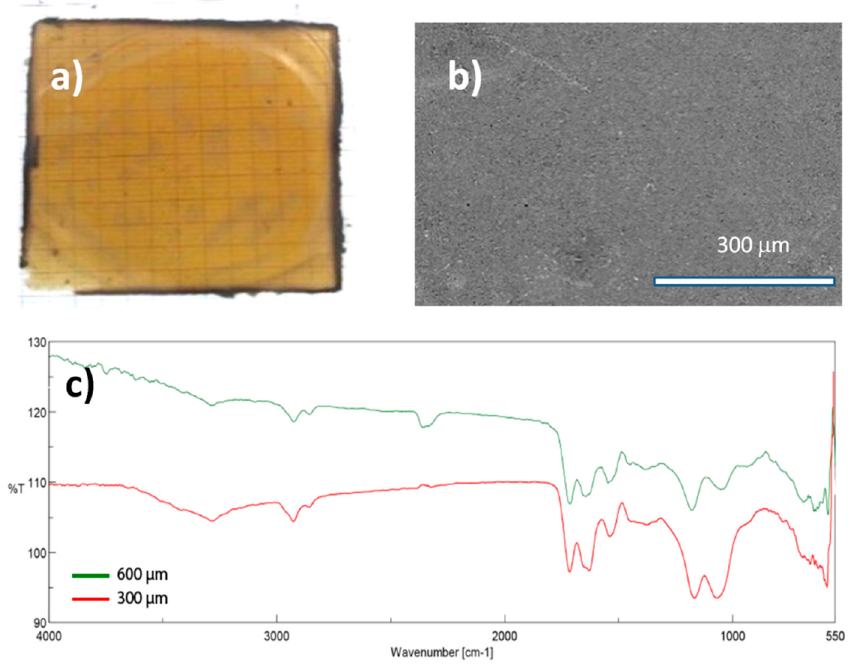
Figure 4. ( a ) Photographs of bioplastic from 300 µm rapeseed cake; ( b ) FE-SEM picture of film morphology from 300 µm rapeseed cake; ( c ) FT-IR spectra of bioplastic films from 300 and 600 µm particle size.